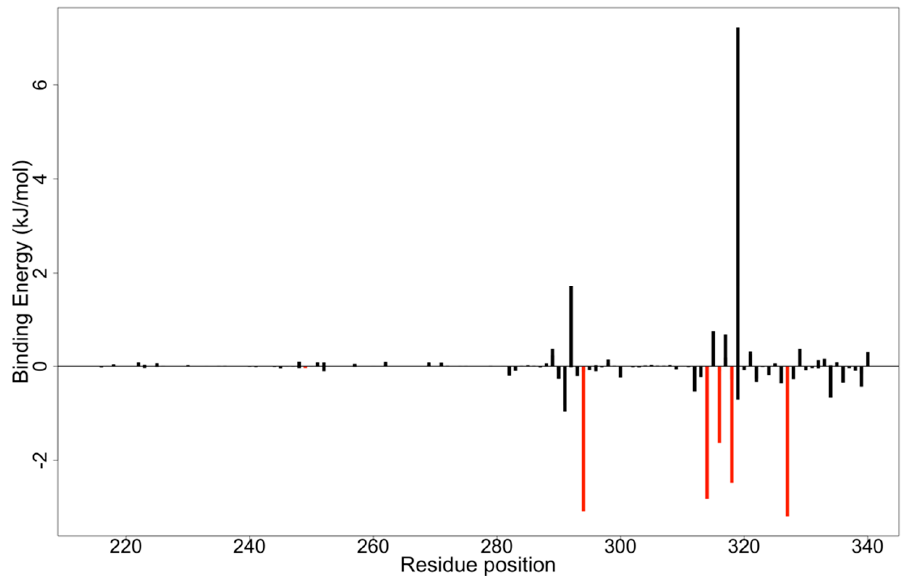
Table 7. The free energy terms for the binding of compounds to the EBOV VP35 protein. The energy values are presented as average ± standard deviations in kJ/mol. The binding affinity scores from the docking studies are represented as “kcal/mol (kJ/mol)”, where the calculated binding affinity in kJ/mol are presented in brackets.